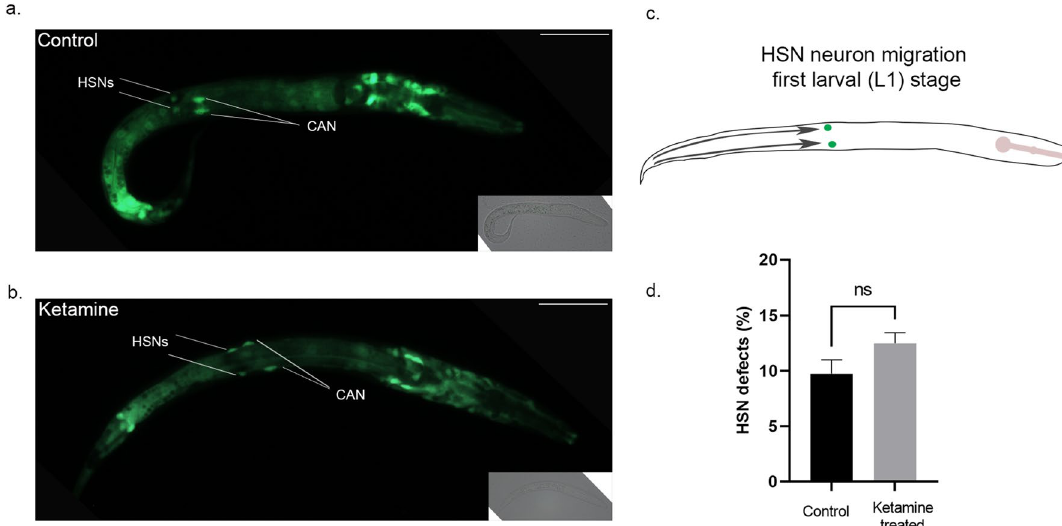
Figure 4. HSN cell bodies migrate to the correct body position in ketamine-treated animals at first larval stage ( a ) Control animal at first larval stage (L1) expressing kal-1::GFP reporter marker in hermaphrodite specific neurons (HSN) and Canal Associated Neurons (CAN) is shown ( b ) Ketamine-treated animals at L1 stage expressing kal-1::GFP reporter do not show HSN migration defects ( c ) Illustration of HSN migration at first larval (L1) stage. HSNs are born in the tail during embryogenesis and migrate towards midbody of the worm ( d ) Migration defects of control (n = 172) and ketamine-treated animals (n = 156) were compared. Four biological